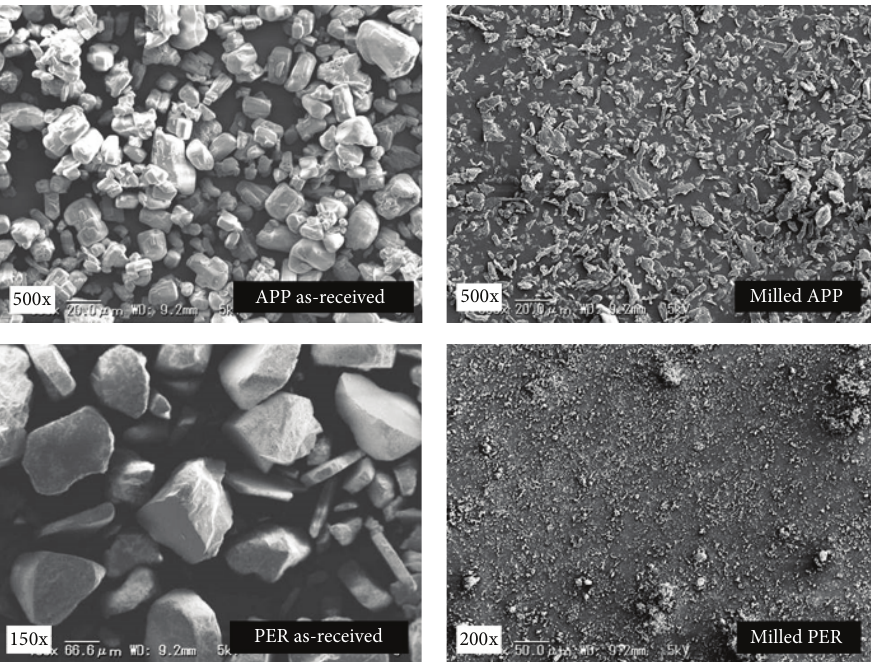
Figure 1: SEM micrographs of APP and PER additives before and after milling.